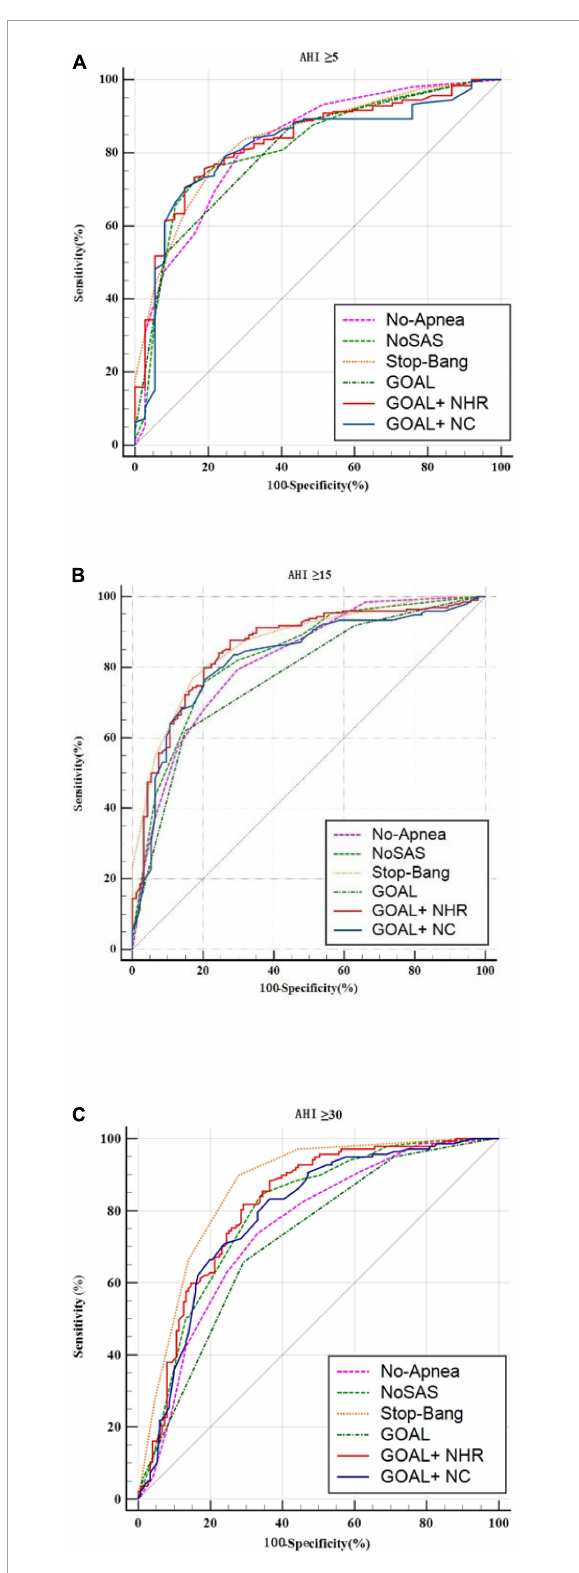
FIGURE1 ROC curve of the six screening tools at apnea-hypopnea index (AHI) cut-off points of (A) ≥ 5, (B) 15, and (C) 30